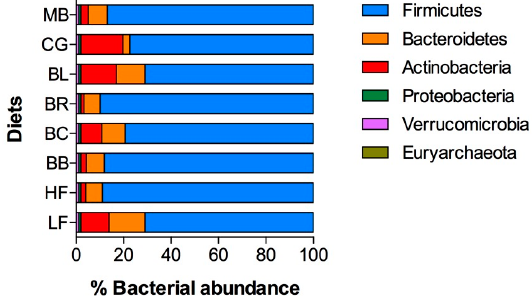
Figure 5. Changes in gut microbiota profiles following 12-week berry supplementation.